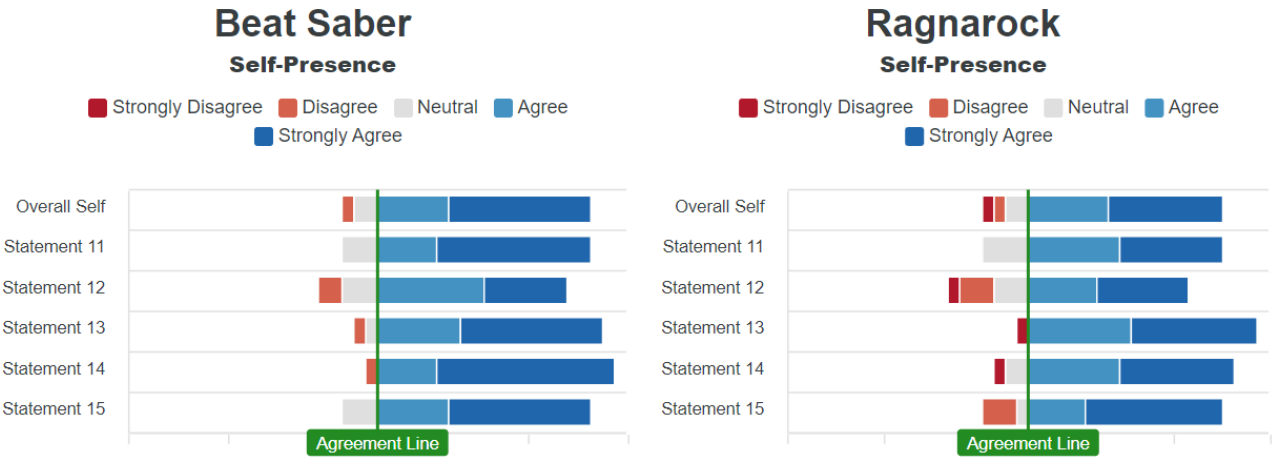
Figure 4. Comparison between self presence ratings for Beat Saber and Ragnarock. This shows very high results for self presence in both titles, but no significant differences overall or for any of the